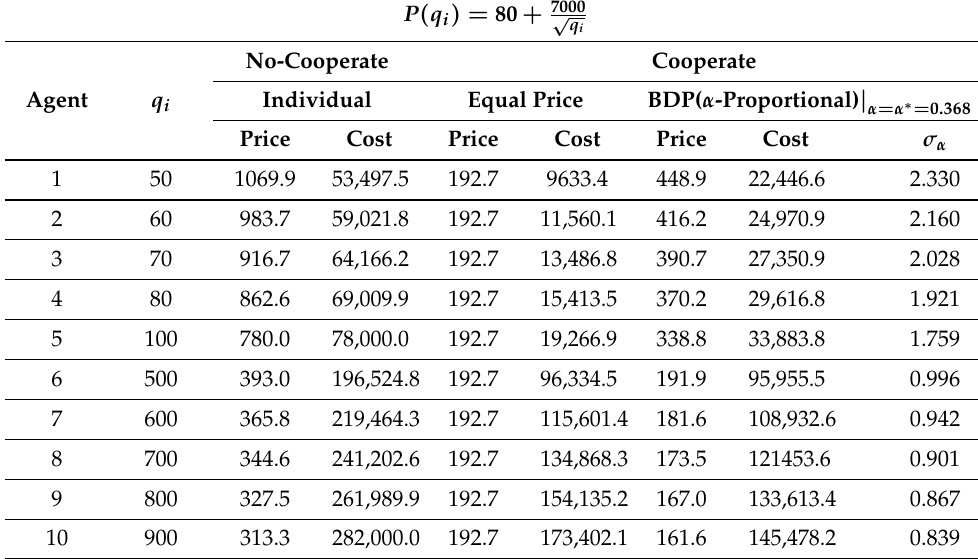
Table 1. Example 1 with α ∗ >